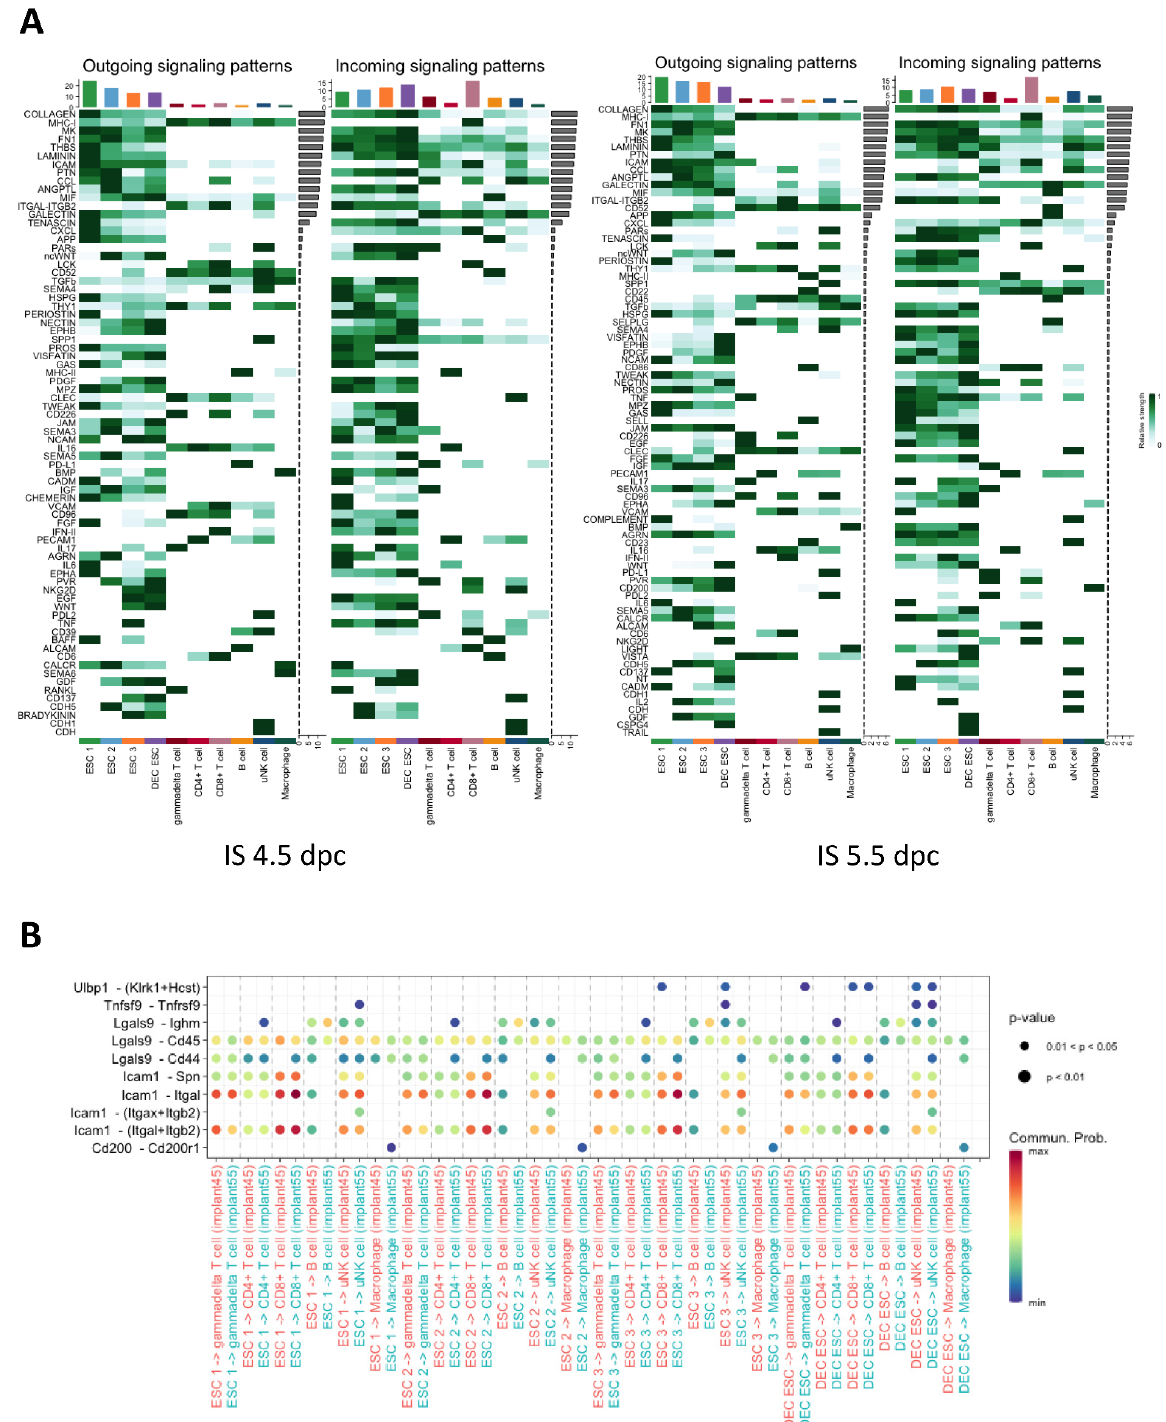
Figure 7. The ligand–receptor interaction between the ESCs and uterine lymphocytes during early mouse embryo implantation. ( A ) The outgoing and incoming signal patterns of ESC and lymphocyte subtypes in the implantation sites at both 4.5 and 5.5 dpc. ( B ) Comparison of the significant ligand–receptor pairs between the ESCs and lymphocytes in the implantation sites between 4.5 and 5.5 dpc. Dot color reflects the communication probabilities, and dot size represents the computed p values. The p values were computed from the one-sided permutation test. Empty squares show that the communication probability is